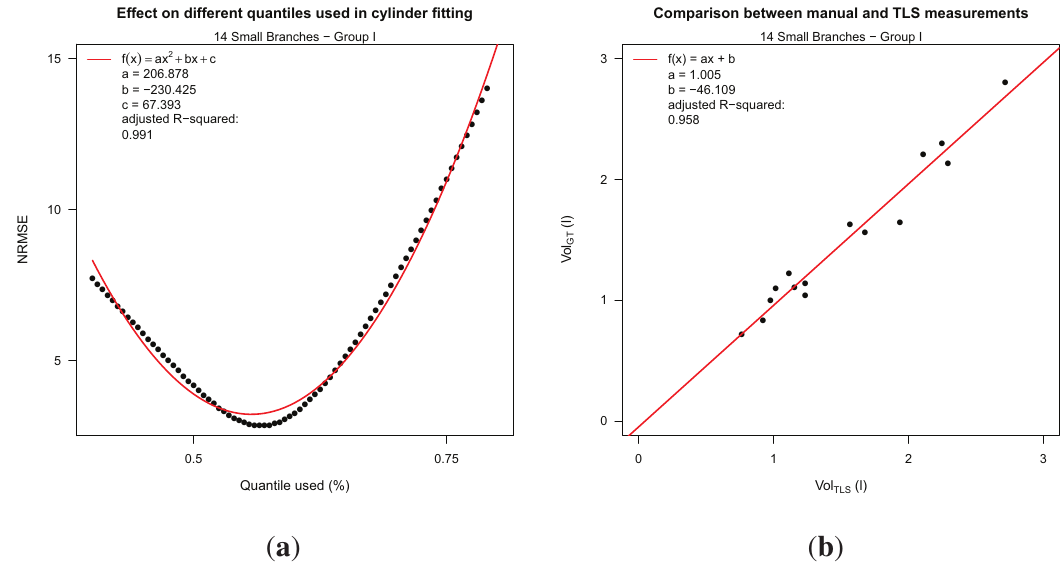
Figure 4. Group I results: (a) normalized root mean square error (NRMSE) in dependency of the quantile used for the quantile cylinder fitting method; (b) Linear regression between TLS results and manual volume